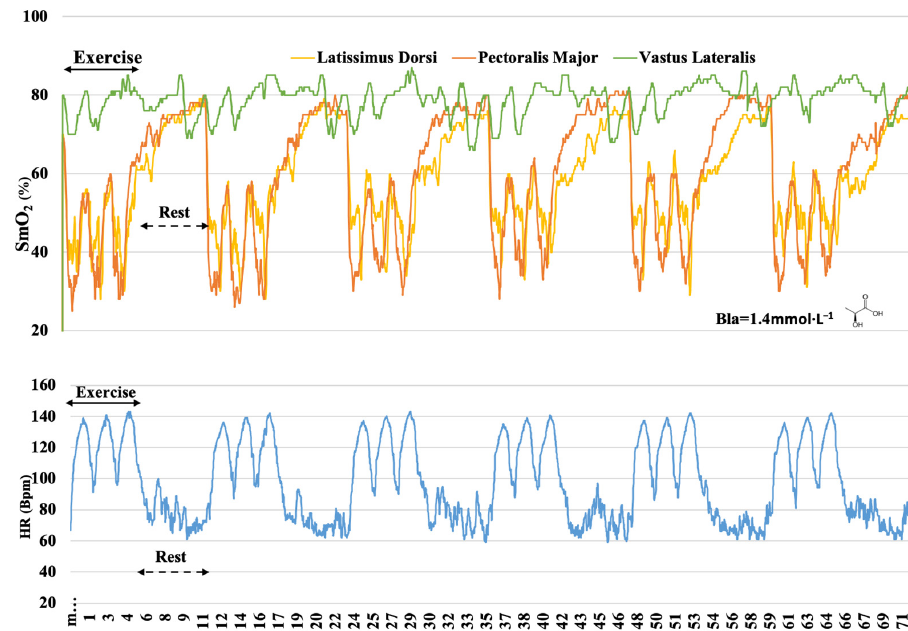
Figure 4. Muscle oxygen saturation (SmO 2 ) kinetics in latissimus dorsi, pectoralis major, and vastus lateralis and heart rate (HR) response during IT protocol; blood lactate (Bla) concentration 3 min after the end of the protocol.